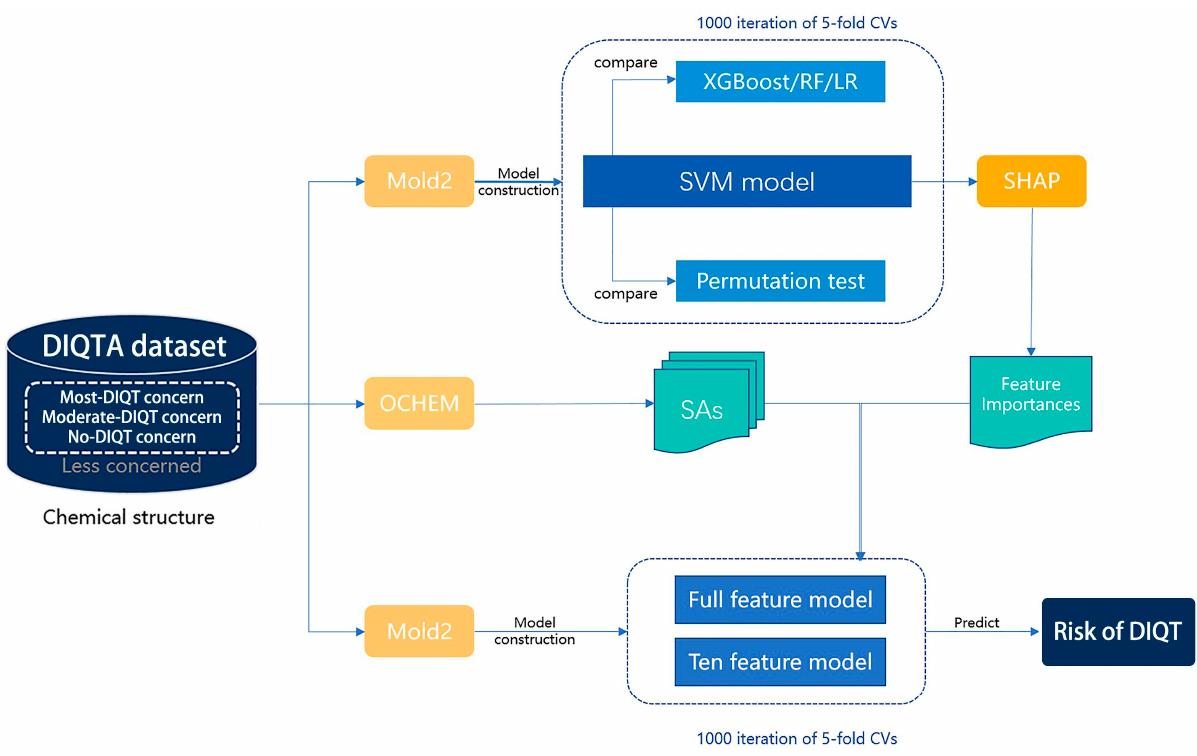
Figure 5. Workflow of our study.